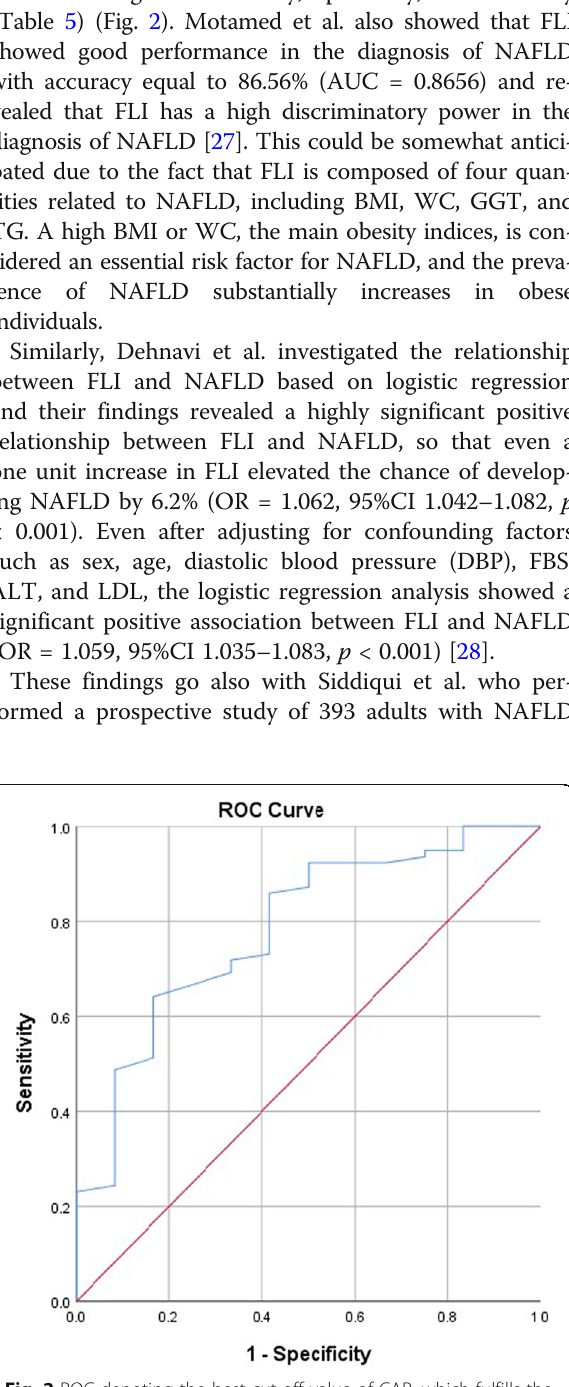
Fig. 2 ROC denoting the best cut-off value of CAP, which fulfills the highest sensitivity and